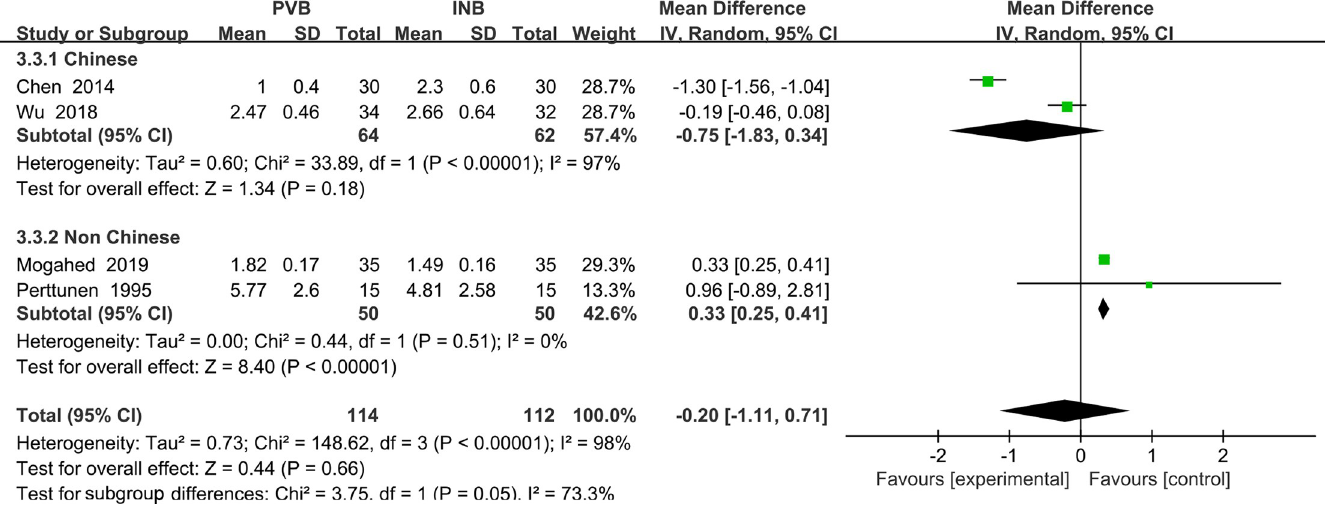
Fig 4. Subgroup analysis of comparison: Chinese VS non Chinese. Outcome: VAS at rest at the first 1 h.